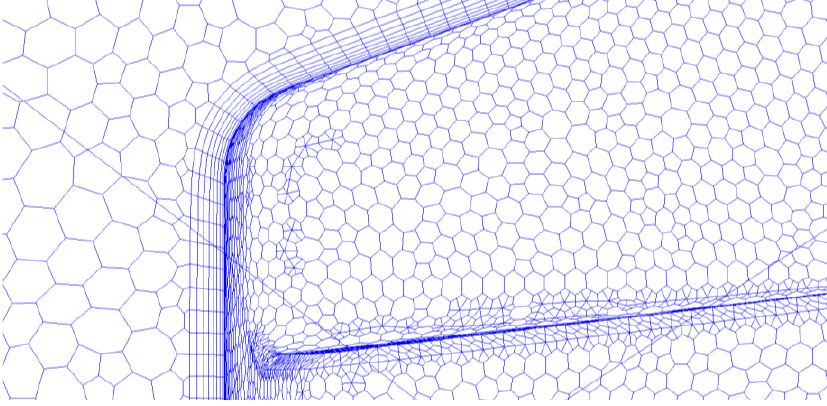
Fig. 4. Inflation layer on the